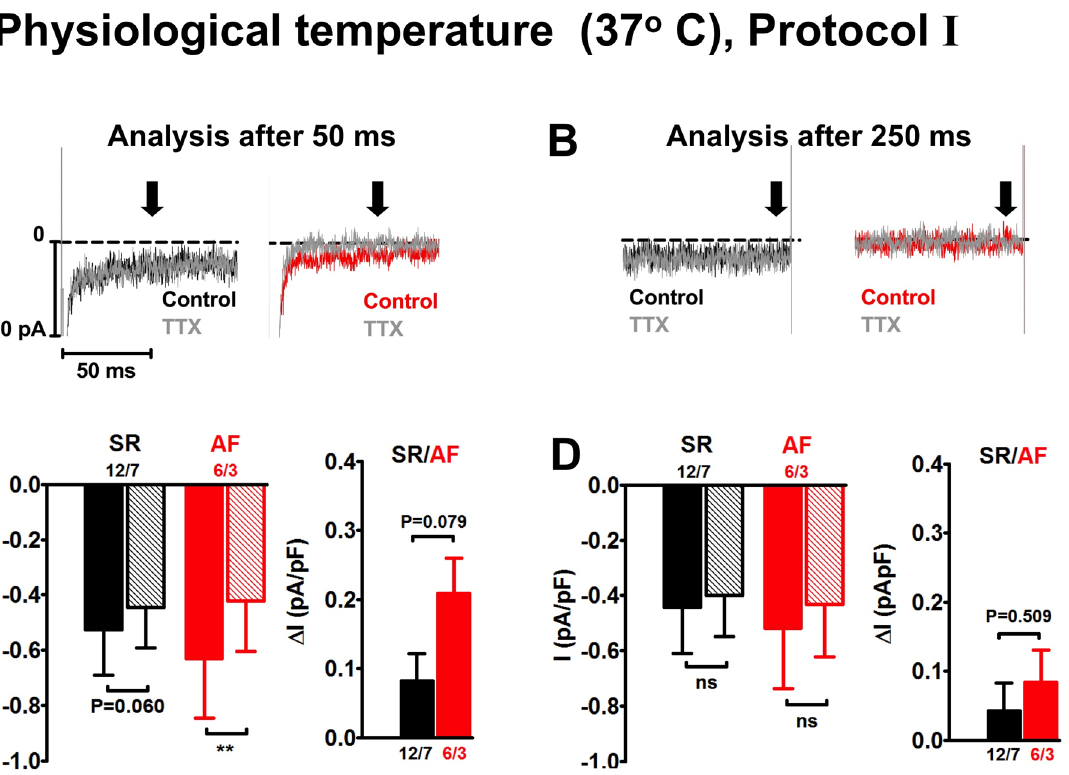
Fig 3. Effects of tetrodotoxin on I Na,late measured at physiological temperature (37°C) with protocol I in human atrial myocytes 50 ms (A, C) and 250 ms (B, D) after Na + channel activation. Similar lay-out as in Fig 2, but without I/V curves.